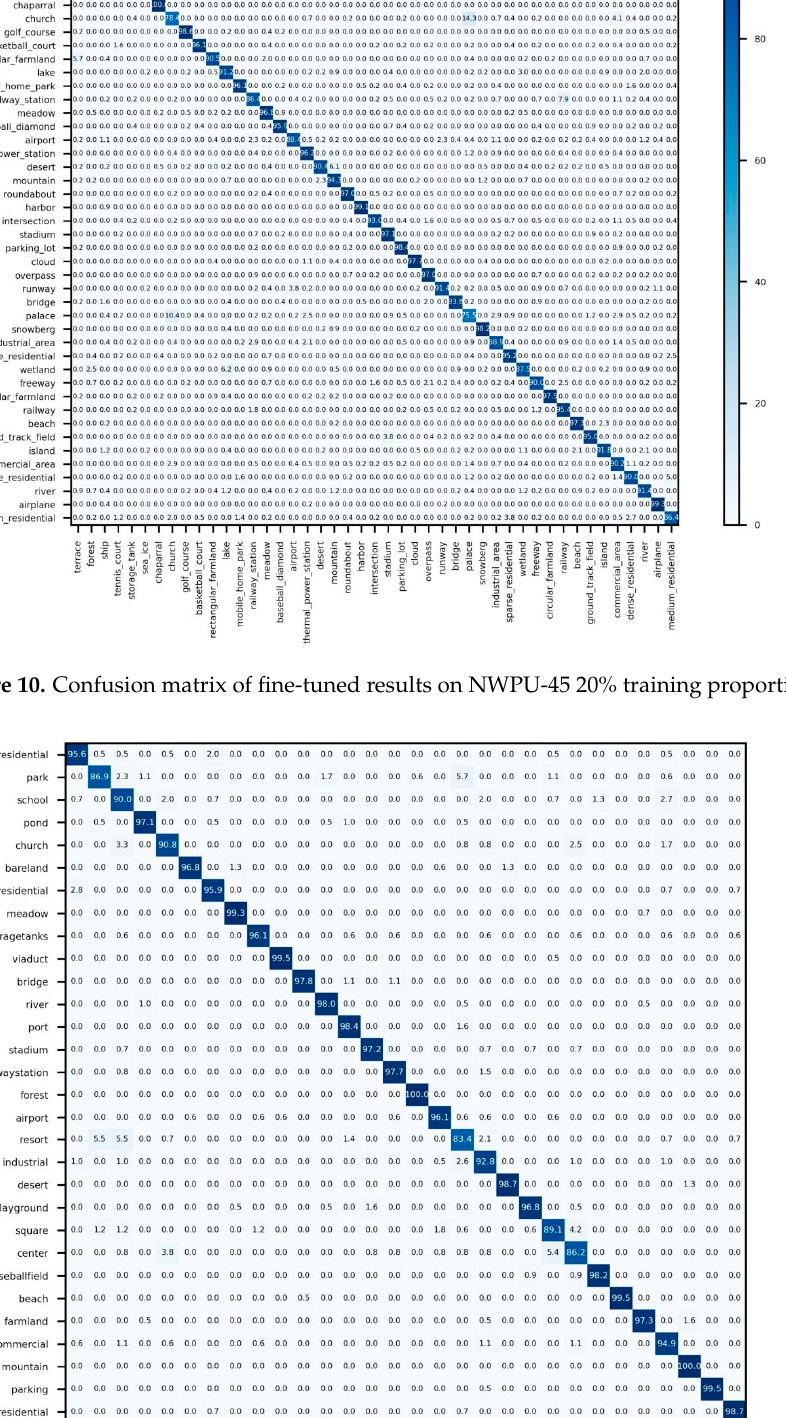
Figure 12. The flowchart of Lite-SRL’s deployment corresponds to the content in the following. N- Layers corresponds to Figure 13a; Statistic the Memory Usage corresponds to Figure 13b; Statistic the Time Consumption corresponds to Figure 13c; Candidate Partition Points corresponds to Figure 14a; Best Partition Point corresponds to Figure 14b.